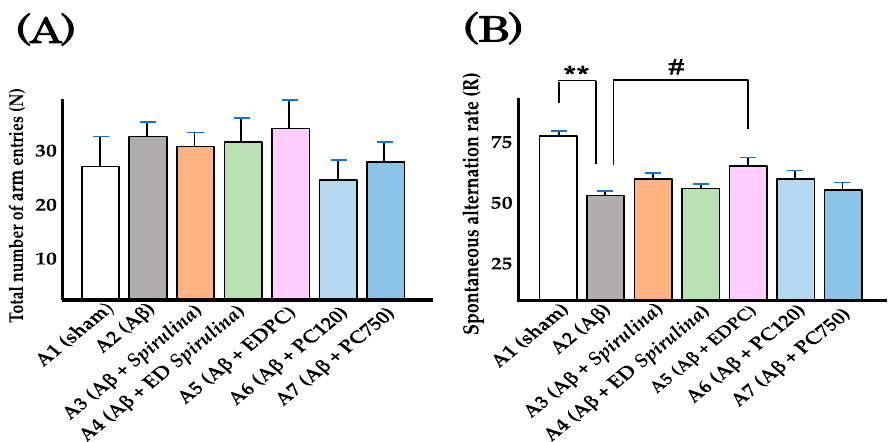
Figure 2. Total number of arm entries and spontaneous alternation ratio: ( A ) total number of arm entries (N). Bars and whiskers represent the mean and SEM, respectively; ( B ) spontaneous alternation ratio (R). Mice of group A6 were treated with 120 mg/kg of PC. ** p < 0.01, A2 (A β ) compared with A1 (sham). # p < 0.05, A5 (A β + EDPC) compared with A2 (A β ).